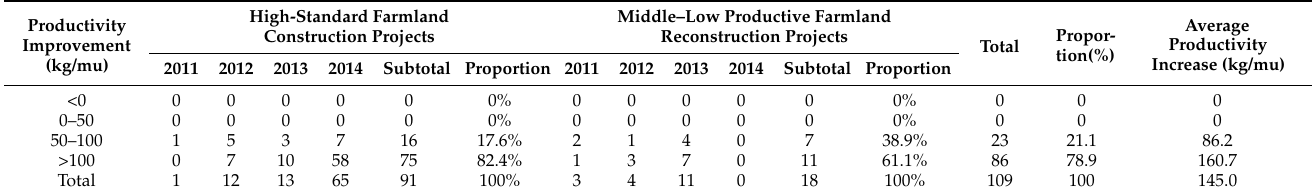
Table 3. Statistics of the improvement level of cropland productivity in the HSF construction project regions and the MLPF transformation project regions.